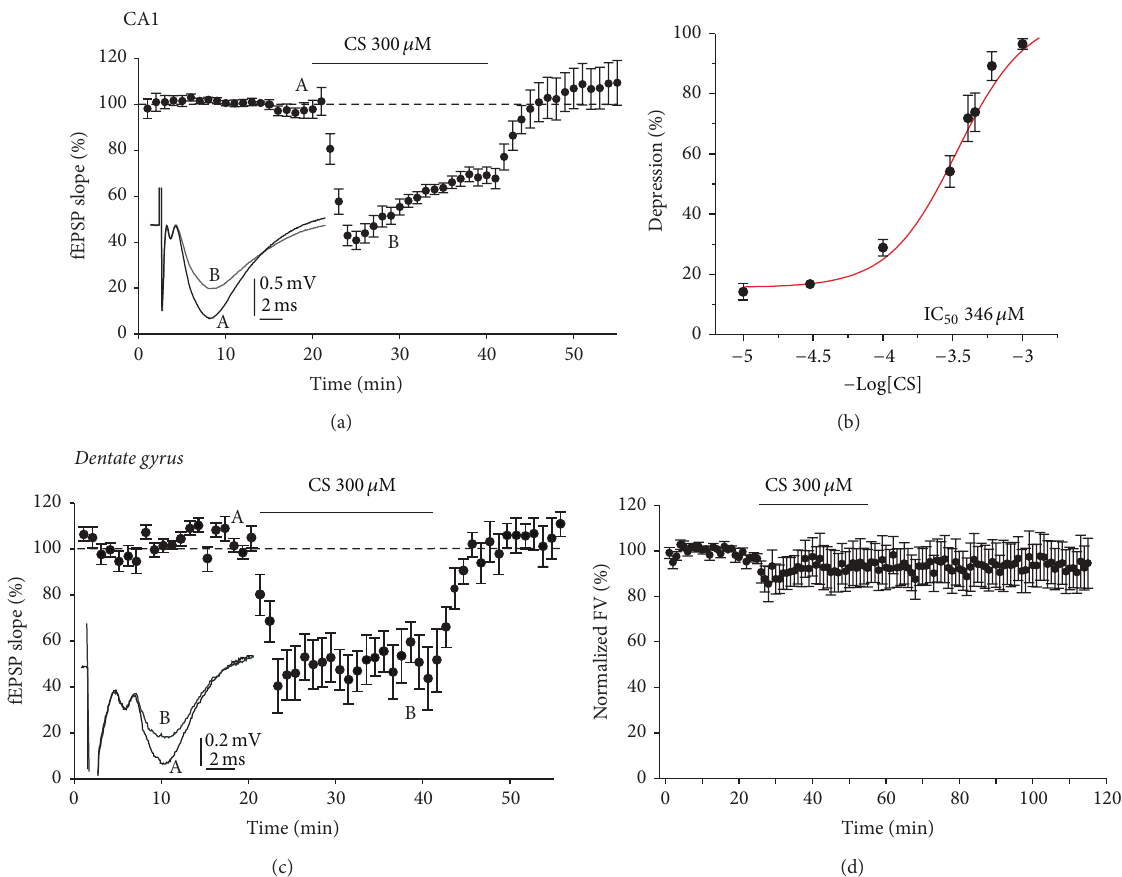
Figure 1: Chondroitin sulfate (CS) reversibly depresses synaptic transmission in the hippocampal slice. (a) Time-course of fEPSP slope depression exerted by CS (300 𝜇 M) applied during the time indicated by the top horizontal bar. Every dot represents the minute-averaged fEPSP slope. Note the fast turn-on and turn-off of effects exerted by CS. Insets A and B represent the original traces of fEPSPs in the points A and B of the time-course curve. (b) Degree of depression caused by each concentration of CS at the end of 20min of perfusion. A single concentration of CS per slice was tested. Data were fitted to the concentration-response curve. Data represent the mean ± SEM ( 𝑛 = 4 to 8 slices). (c) Time-course of fEPSP slope in the dentate gyrus measured before, during, and after CS applied during 60min (top horizontal bar). Inset, original traces taken from points A and B of the time-course curve. (d) Time-course of changes on fibber volley (FV) amplitude induced by bath application of 300 𝜇 M CS for the time indicated by the top horizontal bars. Data were normalized to the mean value of the control period and expressed as mean ± SEM/min of 8–13